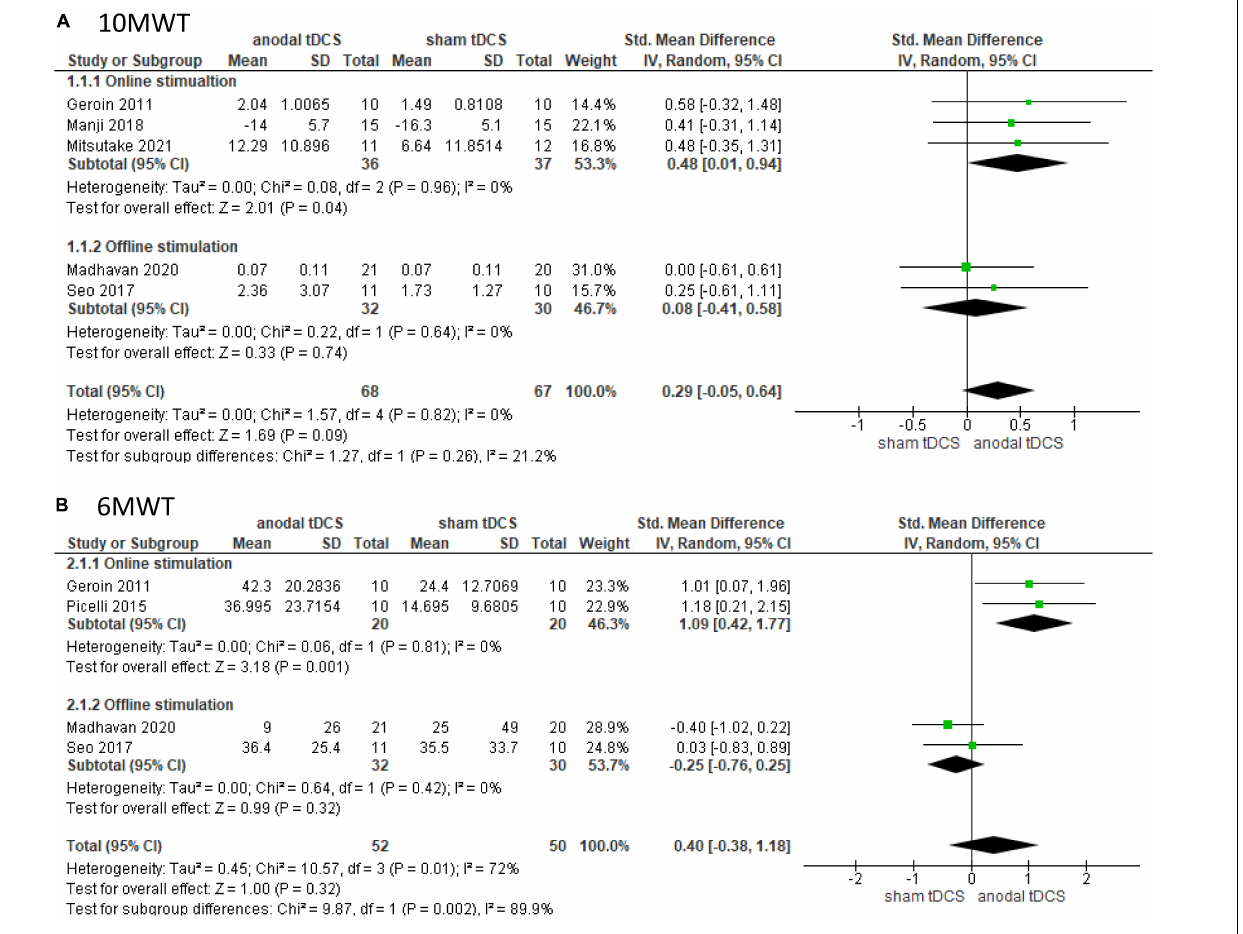
FIGURE 2 | Forrest plot displaying the standardized mean differences (SMD) between anodal and sham tDCSs. (A) Subgroup analysis based on stimulus timing for the 10-m walking test (10 MWT). (B) Subgroup analysis based on stimulus timing for the 6-min walking test (6